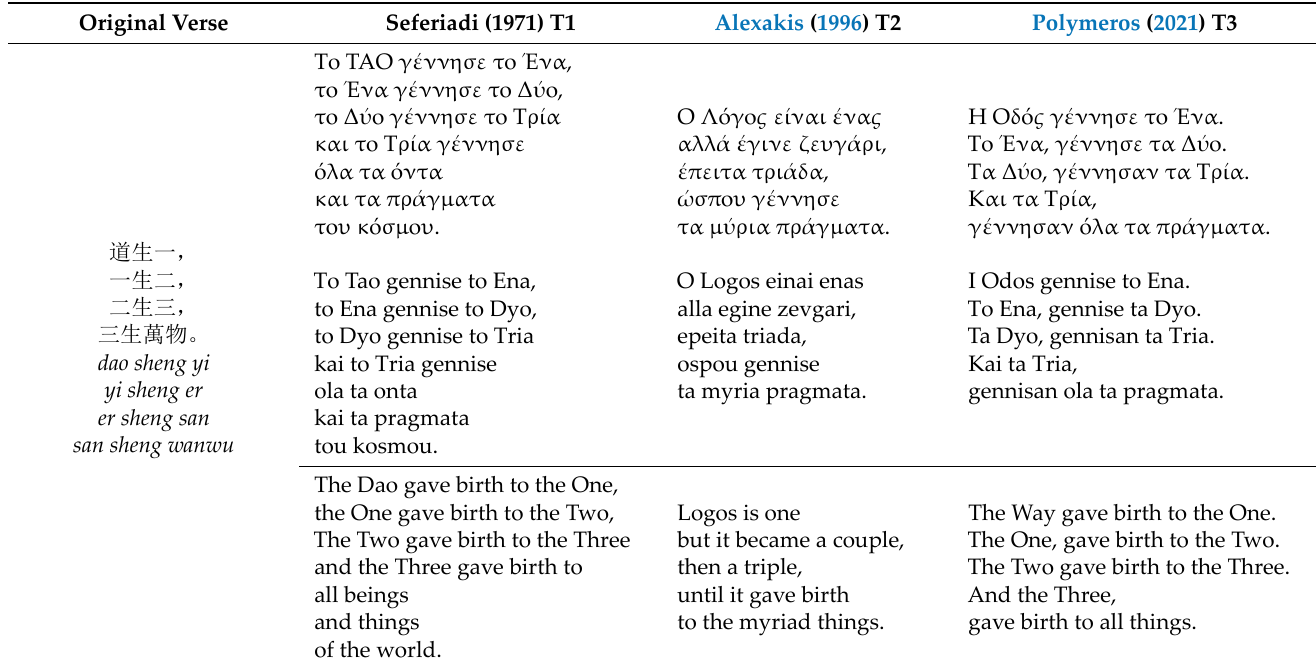
Table 2. Chapter